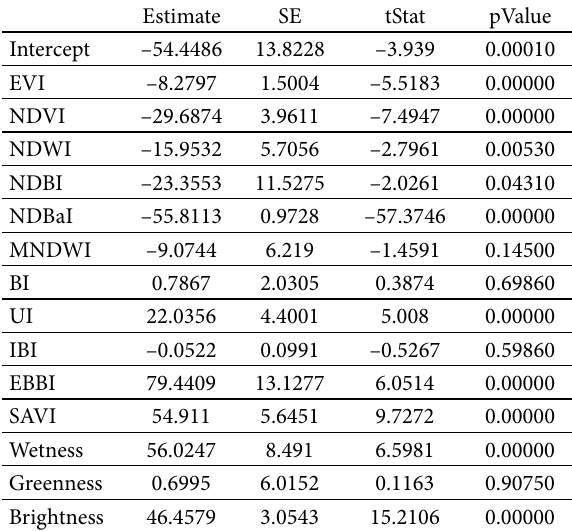
Table 4. The output result of LRM method using full fourteen